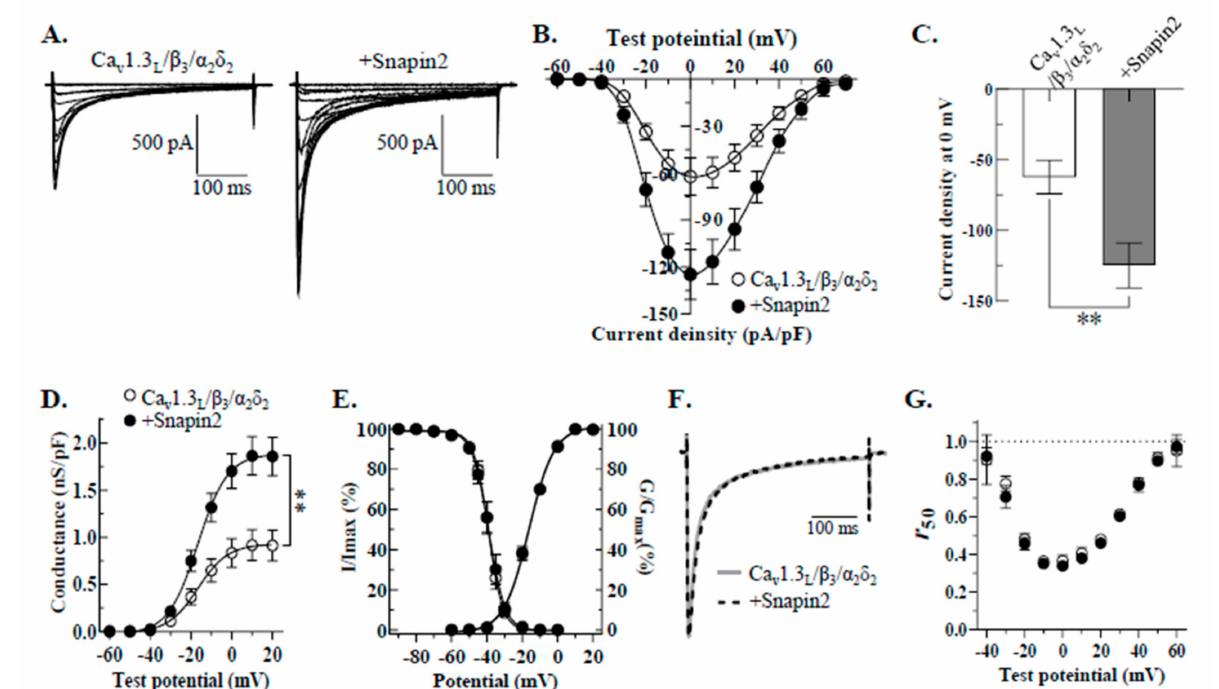
Figure 2. Up-regulation of Ca v 1.3 L channel activity by Snapin2 in HEK-293 cells. ( A ) Representative Ca 2+ current traces through Ca v 1.3 L channels co-expressed without (left) or with Snapin2 (right). Ca v 1.3 L , β 3 , and α 2 δ 2 cDNA constructs were transfected into HEK-293 cells (left) and co-transfected with rat Snapin2 cDNA construct in an equal molar ratio (right). In 10 mM Ca 2+ solution, Ca 2+ current traces through Ca v 1.3 L channels were evoked by application of an I-V protocol consisting of 400-ms depolarizing step pulses from − 60 mV to +70 mV by 10 mV increments from a holding potential of − 80 mV. ( B , C ) I-V relationships of Ca v 1.3 L channels co-expressed without or with Snapin2. Current density values (pA/pF) obtained by dividing the peak current amplitude values of Ca v 1.3 Ca 2+ currents evoked at various test potentials by cell capacitance were averaged and then plotted against test potentials (n = 13–15). ( C ) The maximal peak current density values of Ca v 1.3 L channels co-expressed without or with Snapin2 measured at 0 mV test potential are represented as bar graphs ( − 62.3 ± 11.9 vs. − 124.8 ± 15.9 pA/pF; n = 13–15; Student’s unpaired t -test, p < 0.01, **). ( D ) Snapin2 effect on the chord conductance of Ca v 1.3 L channels. The chord conductance values of Ca v 1.3 L channels without or with Snapin2 were normalized to the cell capacitance, and average values were plotted against test potentials. Snapin2 co-expression increased the maximal conductance of Ca v 1.3 L by roughly 1.9-fold at 10 mV (0.9 ± 0.2 vs. 1.9 ± 0.2 nS/pF; n = 13–15; Student’s unpaired t -test, p < 0.01, **). ( E ) Snapin2 effect on voltage-dependent channel activation and channel availability of Ca v 1.3 L channels. The chord conductance values of Ca v 1.3 L channels without or with Snapin2 were normalized and superimposed (n = 13–15). Channel availability of Ca v 1.3 L channels was evaluated by a two-step pulse protocol consisting of 10-s pre-conditioning pulses ranging from − 90 mV to 0 mV by an increment of 10 mV, followed by a step pulse to 0 mV. Currents measured at 0 mV test potential were normalized to the current amplitude after a preconditioning potential of − 90 mV and plotted against pre-pulse potentials. The average percentage data were fit to the Boltzmann equation (n = 10–12). ( F , G ) Snapin2 effect on CDI of Ca v 1.3 L channels. ( F ) Ca v 1.3 L Ca 2+ current traces through Ca v 1.3 L channels without or with Snapin2 at 0 mV test potential were normalized and superimposed, exhibiting little difference in CDI. ( G ) Snapin effect on r 50 . The r 50 values (the fractions of Ca 2+ peak currents remaining after 50 ms; n = 7–8) of Ca v 1.3 L channels without or with Snapin2 were plotted against test potentials. The r 50 values were not altered by Snapin2. No differences in the r 350 values were detected (data not